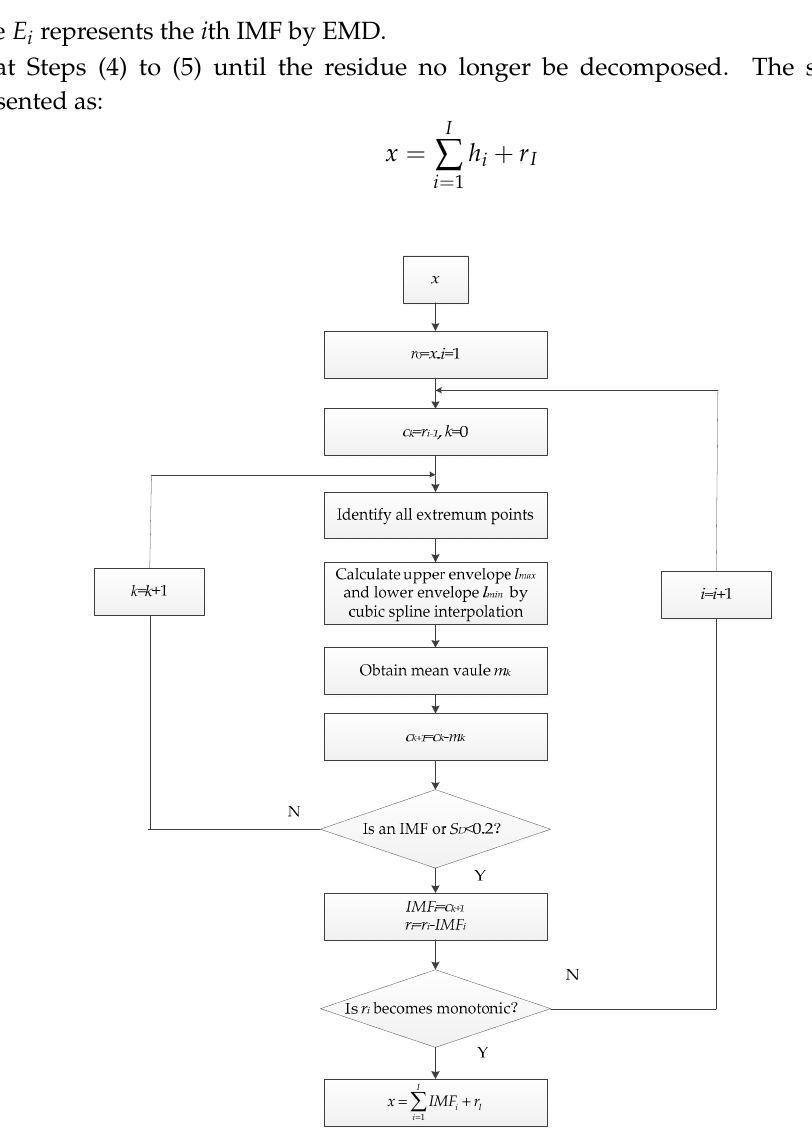
Figure 1. A flowchart of the empirical mode decomposition